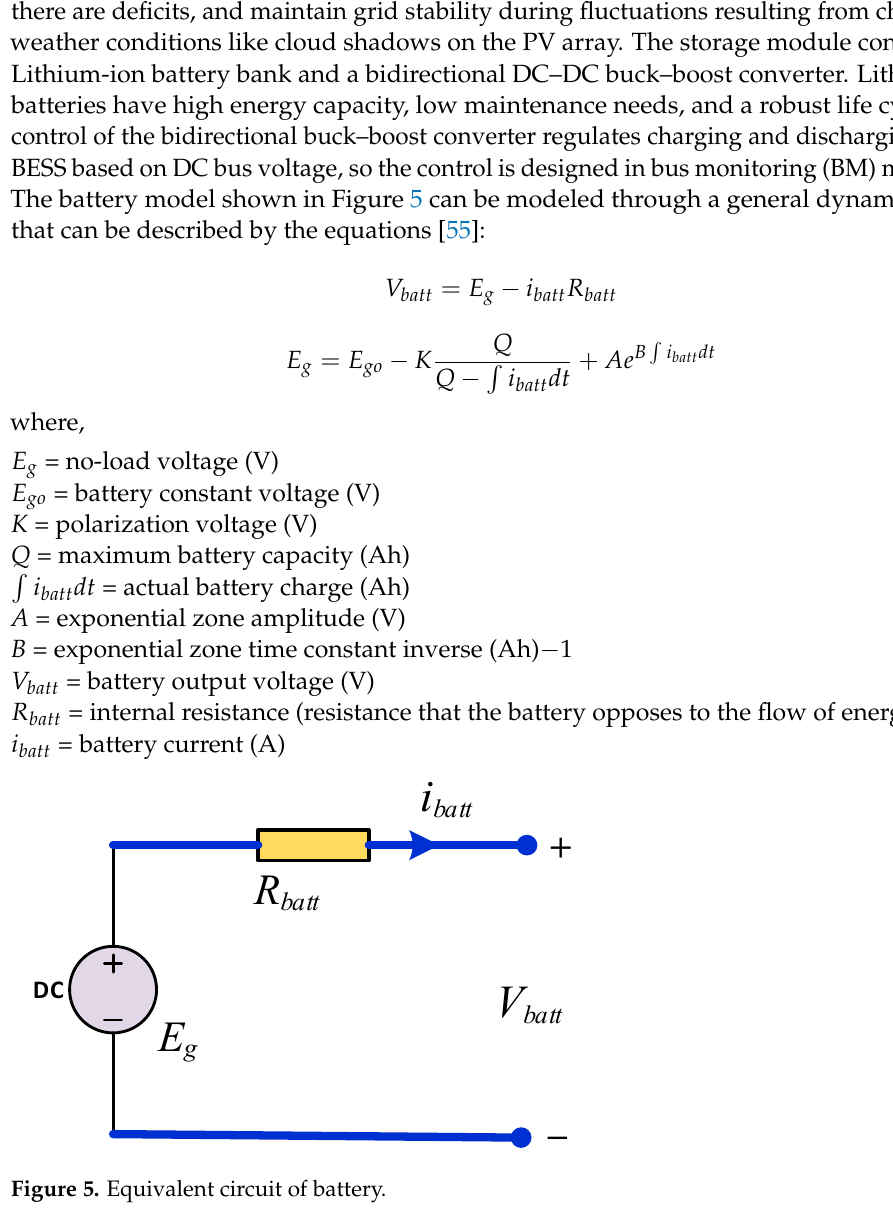
Figure 6. Battery local control.